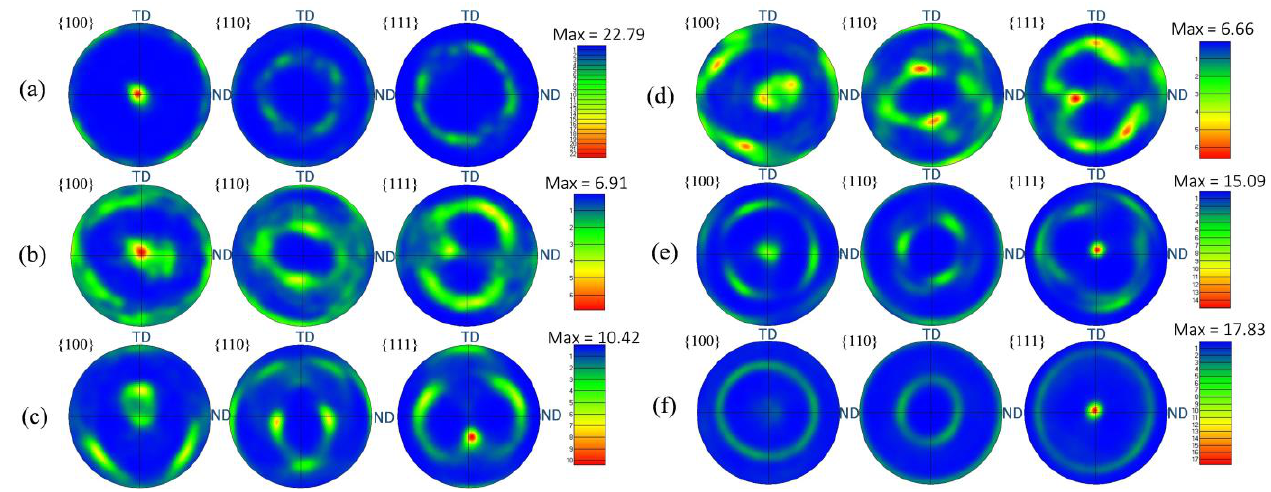
Figure 13. Inverse pole figures of the composites with different drawing reductions: ( a ) 36.0%, ( b ) 67.3%, ( c ) 73.6%, ( d ) 81.6%, ( e ) 91.3%, ( f ) 99.7%.